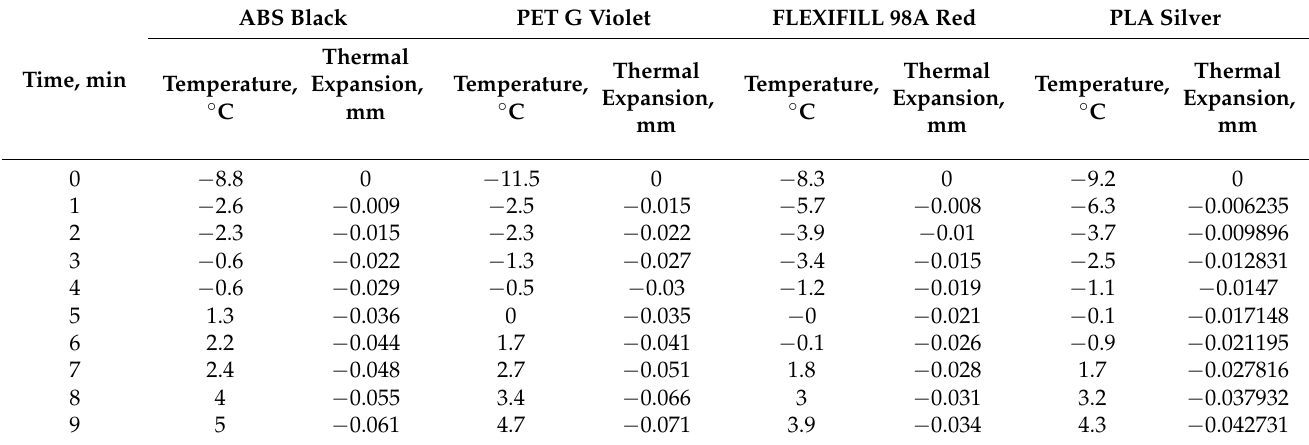
Table 2. Experimental results regarding the thermal expansion of some polymeric